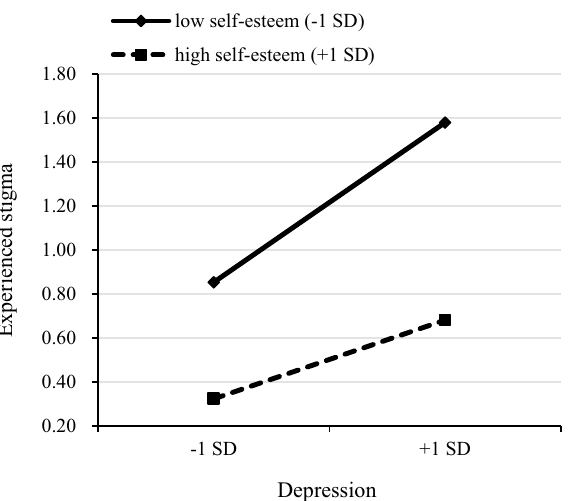
Figure 2. Simple slope plot of interaction between experienced stigma and self-esteem on depression. SD standard